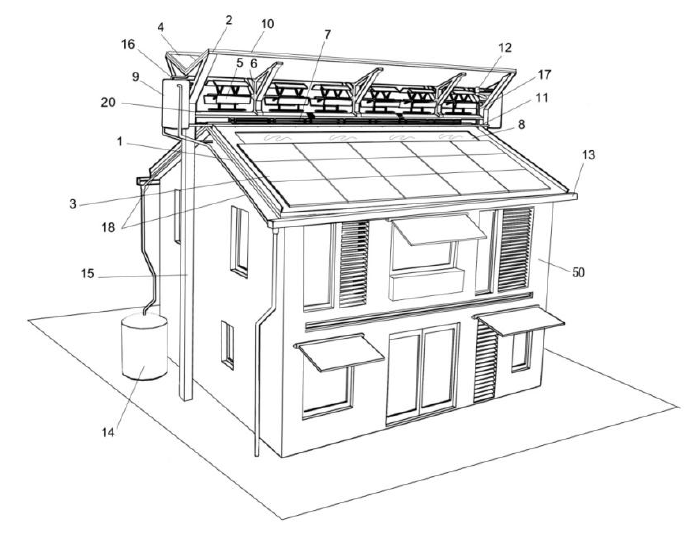
Figure 27. Patent “Harvester Installation on a Building” .